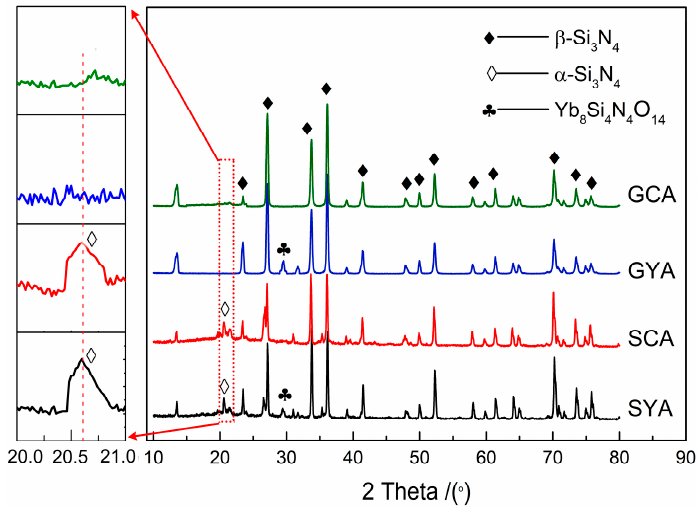
Figure 1. X-ray diffraction (XRD) patterns of the samples obtained by SYA, SCA, GYA, and GCA, where S represents spark plasma sintering (SPS), G represents gas pressure sintering (GPS), CA represents CeO 2 –Al 2 O 3 , and YA represents Yb 2 O 3 –Al 2 O 3 .